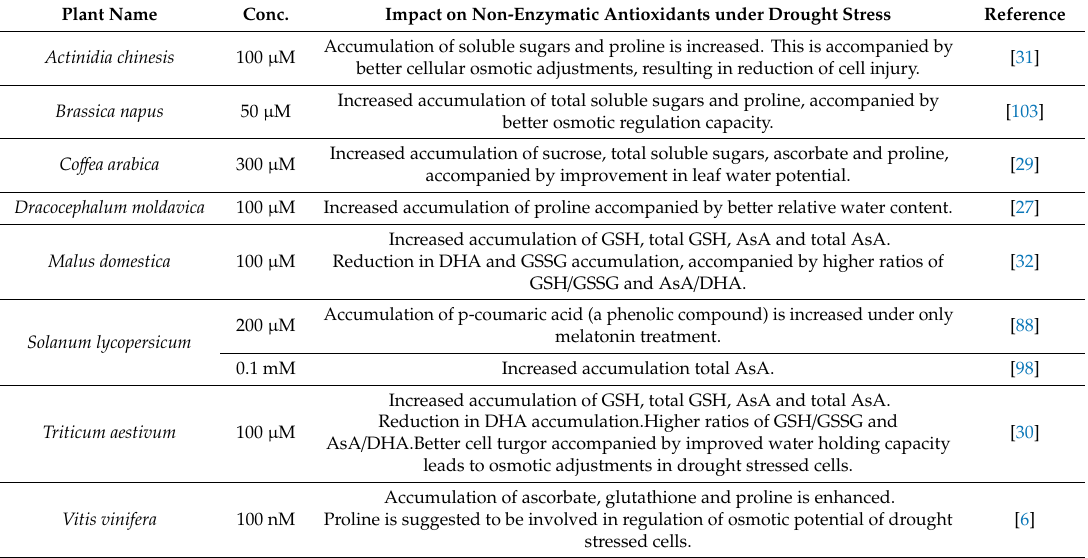
Table 4. Summary table explaining the e ff ect of exogenous applied melatonin on various non-enzymatic antioxidants and osmotic adjustments under drought